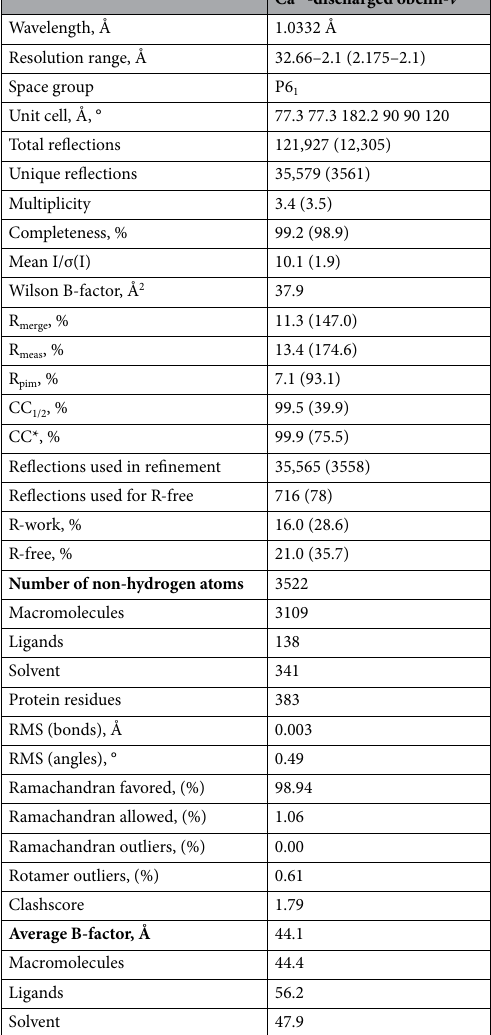
Table 2. Data collection and refinement statistics for Ca 2+ -discharged obelin- v . *Statistics for the highest- resolution shell are shown in